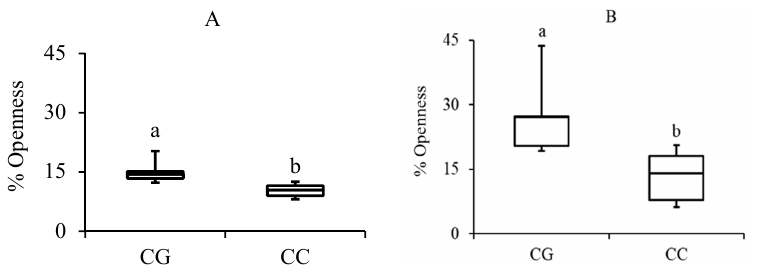
Figure 3. Percent openness for Canopy Gap (CG) plots and Canopy Closed (CC) plots for the new ( A ) and old ( B ) infestation sites. Boxes represent the 25th and 75th quartiles, and the horizontal line the median. The whiskers represent the maximum and minimum average plot values for the sites. Boxes with different letters indicate significant differences between the sites (Student’s t ‐ test: new p = 0.002, old p = 0.03).